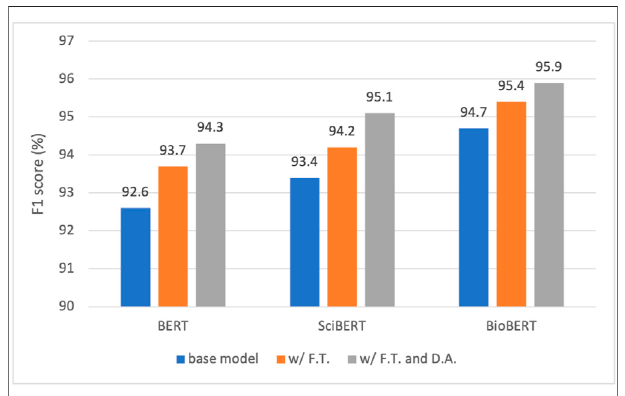
FIGURE 7 | Performance comparison of BERT, SciBERT, and BioBERT in F1 score under three training settings: base model, with fi ne tuning (F. T.), and with F. T. and data augmentation (D. A.).